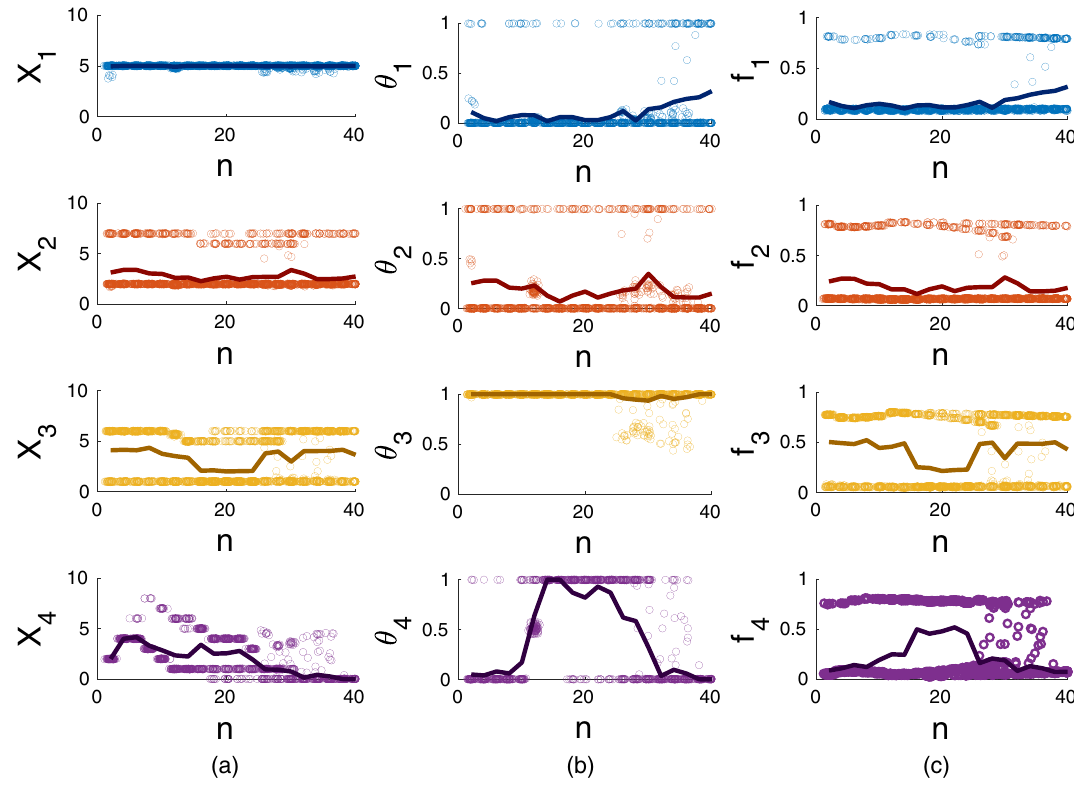
Figure 6. Effects of the group size n on the number of contributing individuals in a group X ( a ), the cooperation status of a group θ ( b ) and group power f ( c ). Each point corresponds to an outcome of a particular run. The values of θ larger than 0 but smaller than 1 indicate non-equilibrium dynamics. Characteristics of groups with 5, 10, 15 and n individuals are marked by blue, red, yellow and violet colors respectively. Curves show the average values of corresponding characteristics among all runs. Other parameters: B 1 = 100 , B 2 = 1500 , ε = 0.5 , α = 1 , c = 1 , π 0 = 1 , X 0 = 5 , Z 0 = 300 , µ 1 = µ 2 = 0.25 . These results are based on 100 runs with 4000 time steps for each parameter combination. The outcomes of each run are averages of the last 1000 time steps.